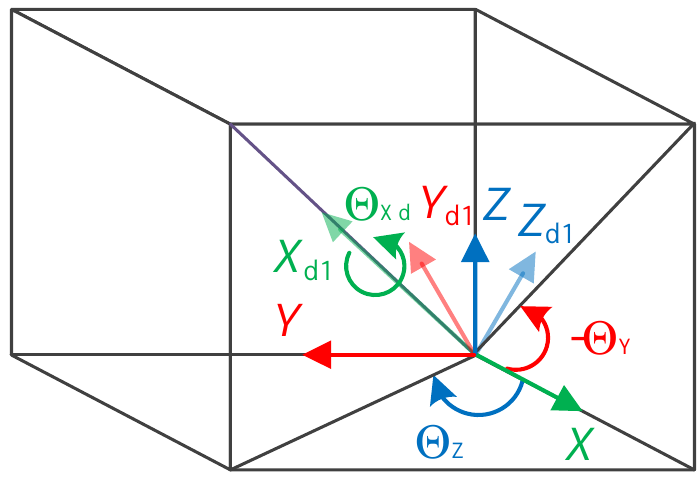
Figure 1. Six-DOF spatial deformation of the FLS.